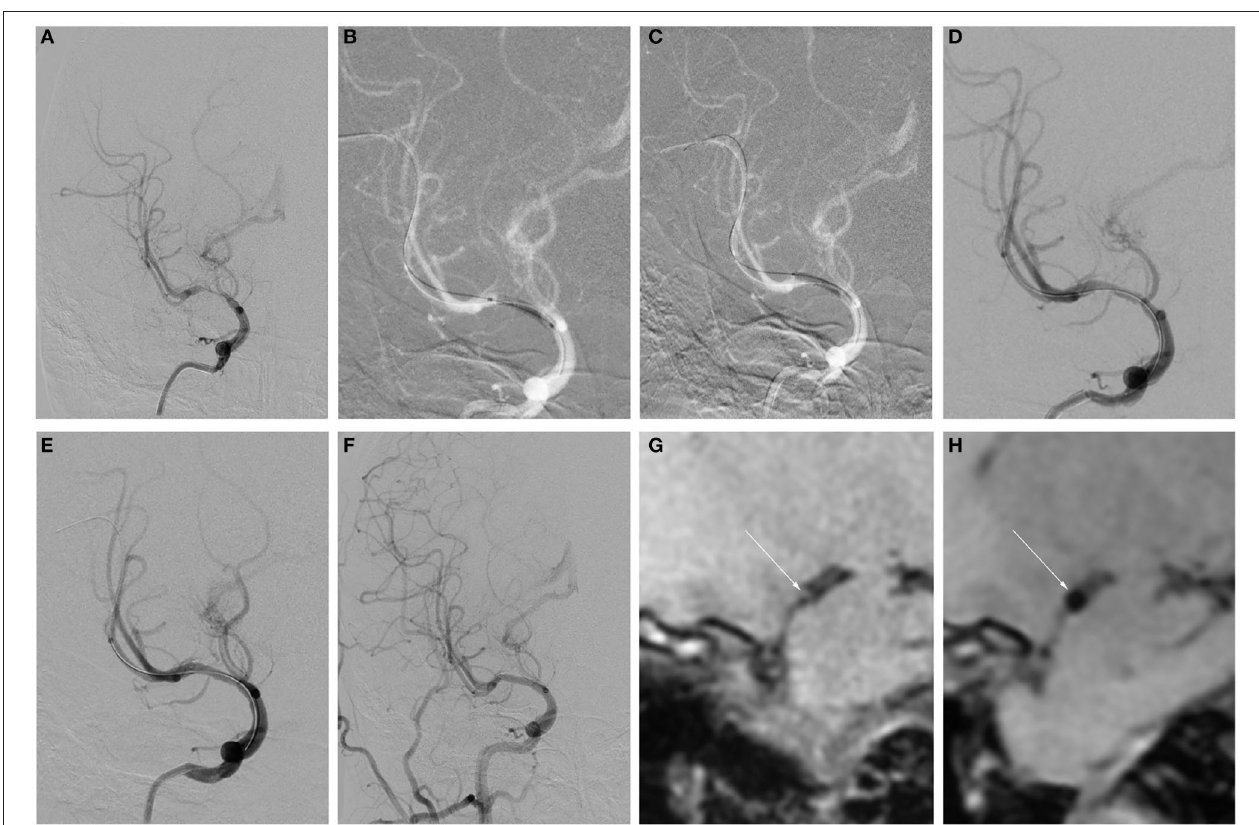
FIGURE 2 | Example of remedial stent implantation after DCB dilatation and follow-up. (A–H) Angiography and HRMRI results of remedial stent implantation after DCB dilatation during the procedure and follow-up. (A) Severe right MCA stenosis. (B) Predilatation with a conventional balloon. (C) DCB dilatation after predilatation. (D) The angiographic result after DCB. (E) The angiographic result after remedial stent implantation. (F) Angiographic result at 5.5-month follow-up. (G) Focal eccentric plaque identified at target vessel wall [arrow in (G) ] in high-resolution T1-weighted imaging sequence. (H) Slight circumferential wall thickening was identified on a high-resolution T1-weighted imaging sequence at a 5.5-month